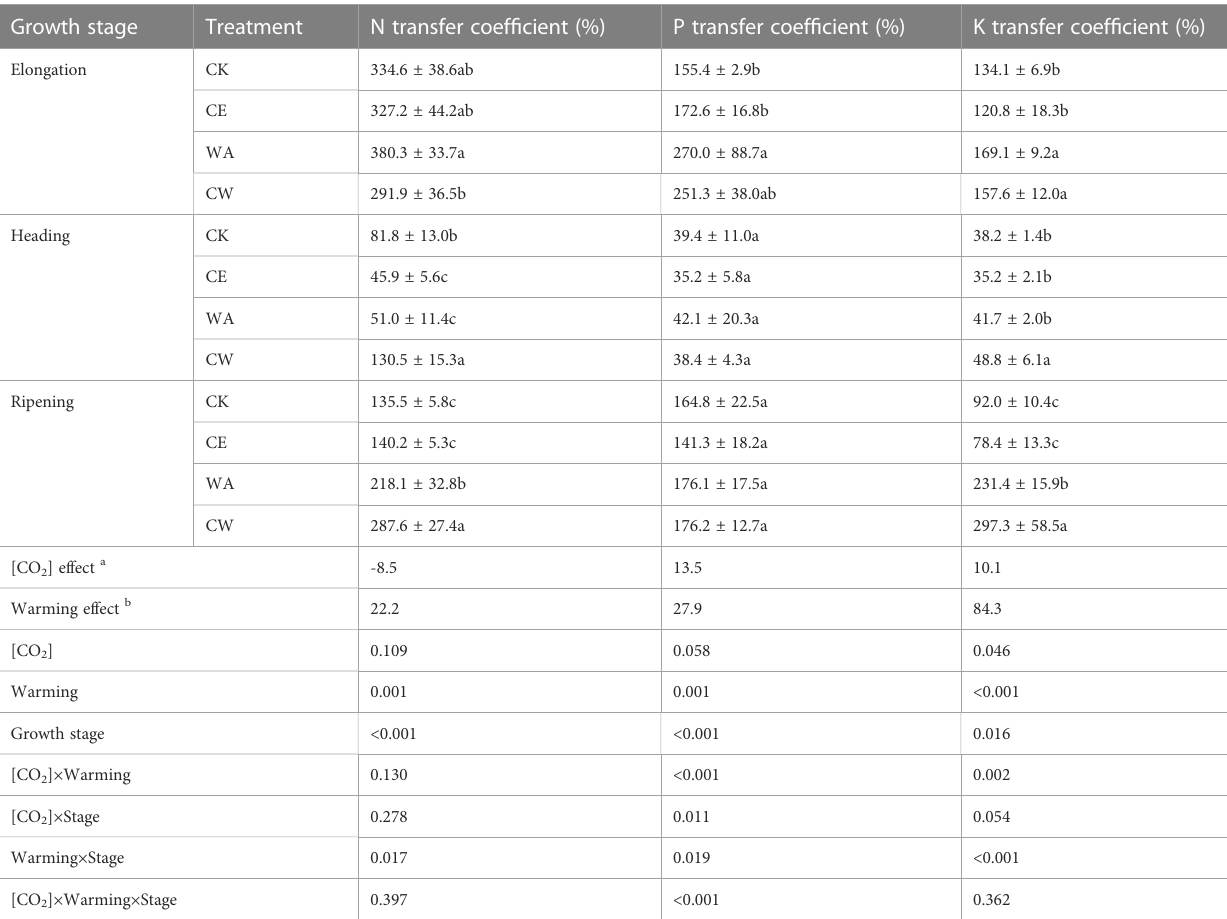
TABLE 2 Nutrient transfer coef fi cients under ambient condition (CK), elevated [CO 2 ] alone (CE), canopy warming alone (WA), and combined treatment